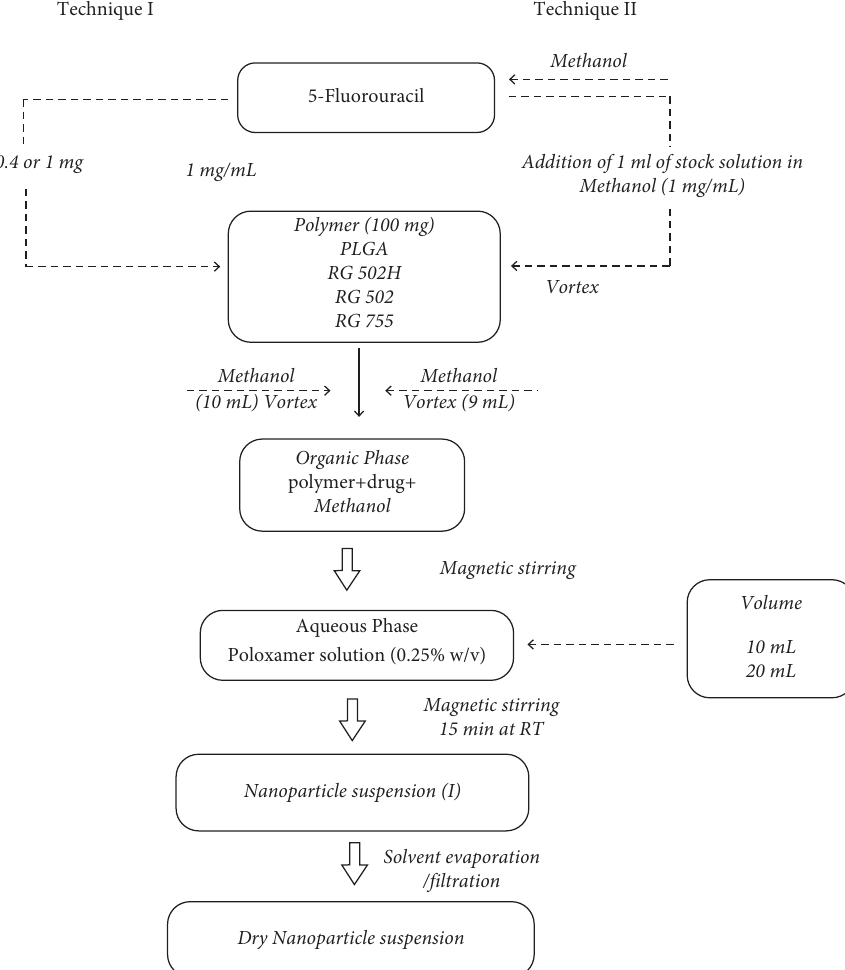
Figure 1: Diagram showing the experimental setup and procedure used to prepare the various